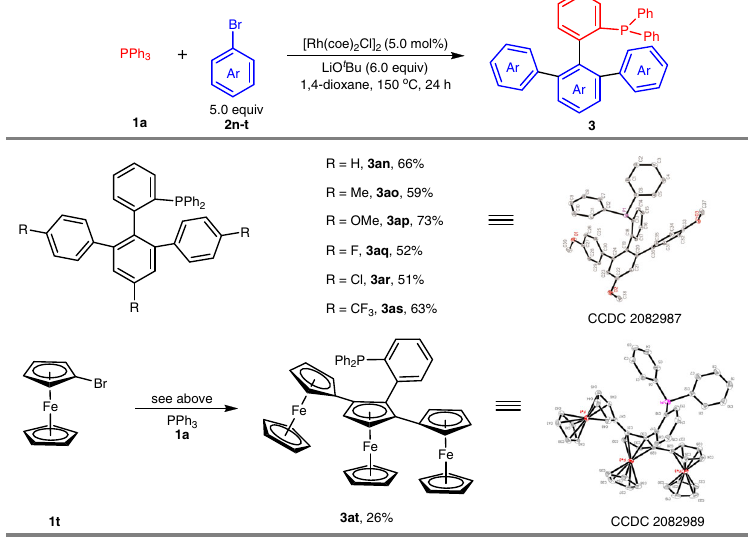
Fig. 4 Substrate scope of threefold direct arylation. Reaction conditions: [Rh(coe) 2 Cl] 2 (5.0 mol %), 1a (0.2 mmol), 2n-t (1.0 mmol), LiO t Bu (1.2 mmol) in 1,4-dioxane (0.5 mL) at 150 °C for 24 h under argon.